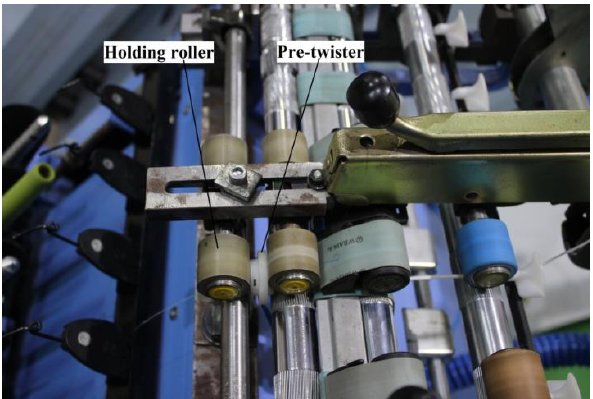
Figure 3. Modified Spintester.